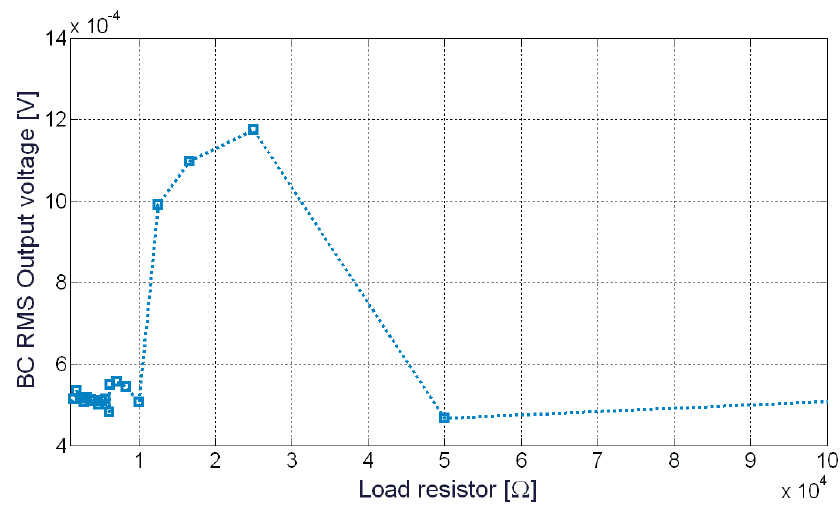
Figure 9. BC output voltage as a function of several resistive loads. The system has been excited with a sinusoidal waveform at 17 Hz and an Root Mean Square (RMS) acceleration level of about 9 m / s 2 .